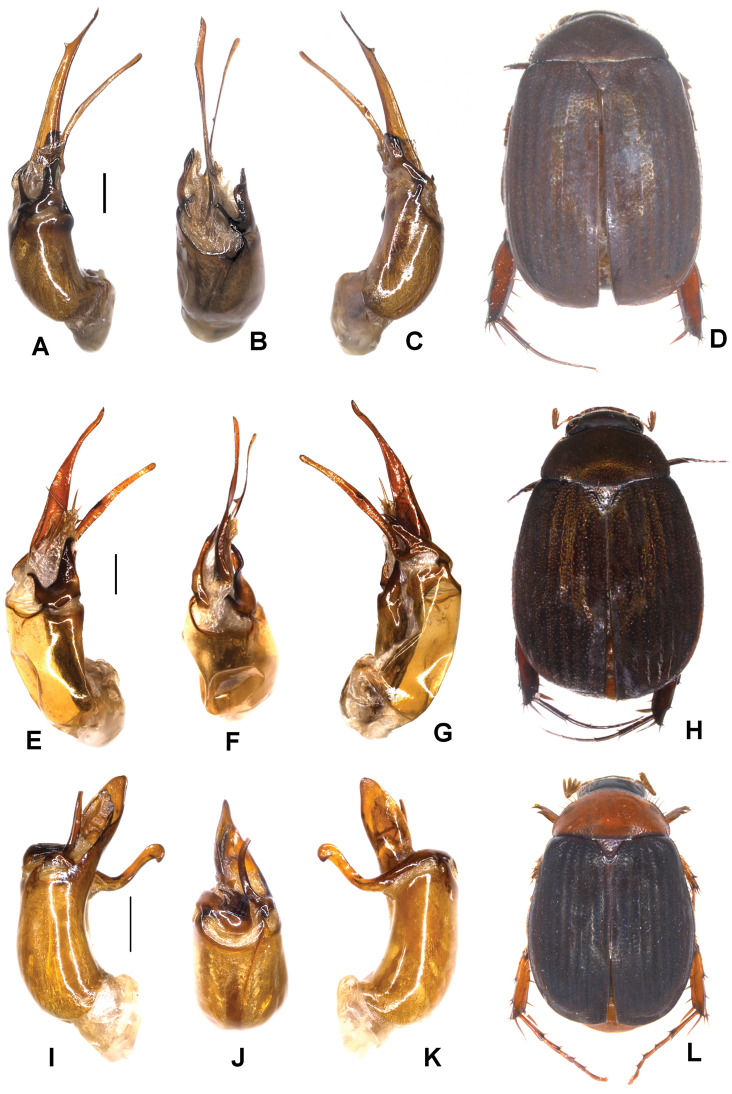
A–DTetrasericasiantarensis (Moser, 1922) (lectotype) E–HTetrasericaferesiantarensis sp. n. (holotype) I–LT.rubrithorax sp. n. (holotype) A, E, I aedeagus, left side lateral view C, G, K aedeagus, right side lateral view B, F, J parameres, dorsal view D, H, L habitus. Scale bars: 0.5 mm. Habitus not to scale.